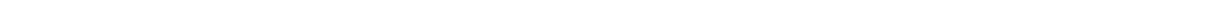
Fig. 5 Environmental regulation of RNA editing in the NFS1 and SFS populations. a Scatterplots comparing average biological replicate 1 and replicate 2 mmPCR-seq editing levels for NFS1 and SFS samples at 25 and 18 °C. Gray points represent sites with > 5% editing level differences between replicates. b Scatterplots comparing the average editing levels of NFS1 and SFS fl ies between 18 and 25 °C. Red dots represent sites with > 5% editing level difference between the temperatures, and FDR-adjusted p -value < 0.05 ( t -test). The number of fl y lines represented for each of these sites per population ranges from 3 to 8 for NFS1 and 3 to 16 for SFS; Supplementary Data 8. c For NFS1 and SFS fl ies, plots comparing predicted RNA structure free energy levels for sites that show < 2% editing level difference between 18 and 25 °C (black), and sites that show > 5% editing at 18 °C than 25 °C (red) ( p -value = 0.0393 for NFS1 lines, p -value = 0.0949 for SFS lines, one-sided KS-test). d For differentially edited mmPCR-seq sites shown in Fig. 3a that had adequate coverage for samples at 18 °C (see Methods section for details), compare average editing level differences at 18 °C (turquoise) and 25 °C (red). Error bars represent standard deviation. The number of fl y lines represented for each of these sites per population ranges from 4 to 8 for NFS1 and 10 to 16 for SFS; Supplementary Data 9. e Plot showing the editing levels of an editing site in falafel that shows an interaction between genetics and environment (FDR-adjusted p -value = 0.065, ANOVA test). Editing levels at 18 °C are shown in turquoise and at 25 °C are shown in red. Error bars represent standard error of the mean. Editing levels for the SFS fl y population are represented by all 16 SFS lines, while those for the NFS1 population are represented by 7 and 8 NFS1 lines for 18 and 25 °C,